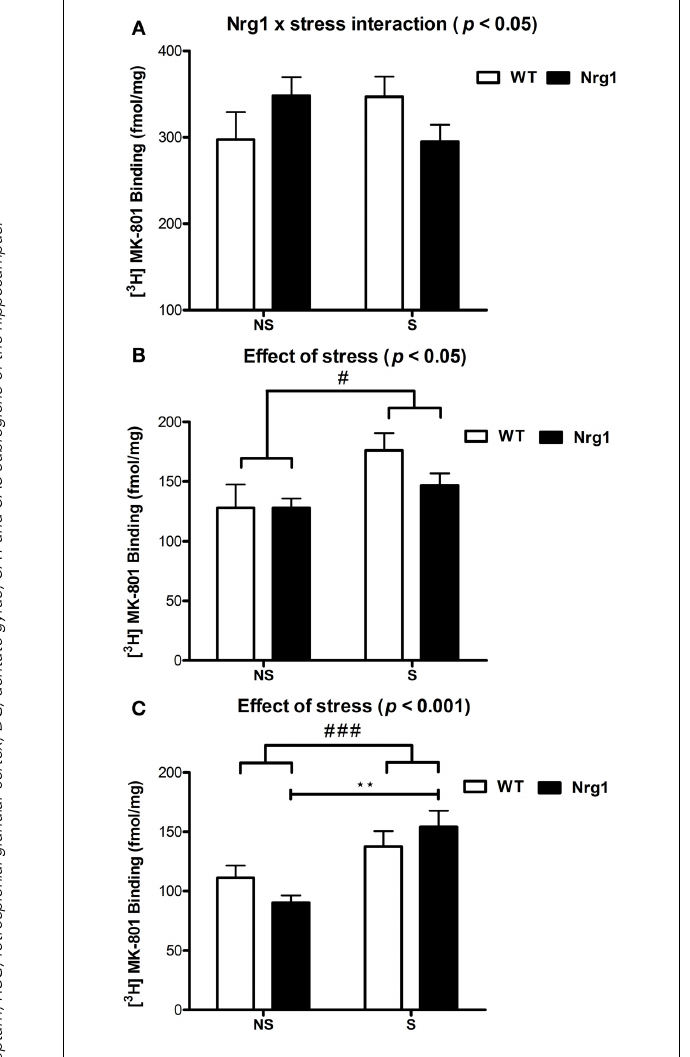
FIGURE 2 | [ 3 H] MK-801 binding to NMDARs (fmol/mg tissue) in (A) infralimbic cortex (IL), (B) ventrolateral septum (LSV) and (C) dentate gyrus (DG) in repeatedly stressed (S) and non-stressed (NS) wild type-like (WT) and Nrg1 HET mice; n = 5–7/group. Data are presented as means ± s.e.m. Significant effects are indicated by # p < 0 . 05 and ### p < 0 . 001 (main effects of stress); ∗∗ p < 0 . 01 [planned Bonferroni comparison, Nrg1 HET (NS) vs. Nrg1 HET